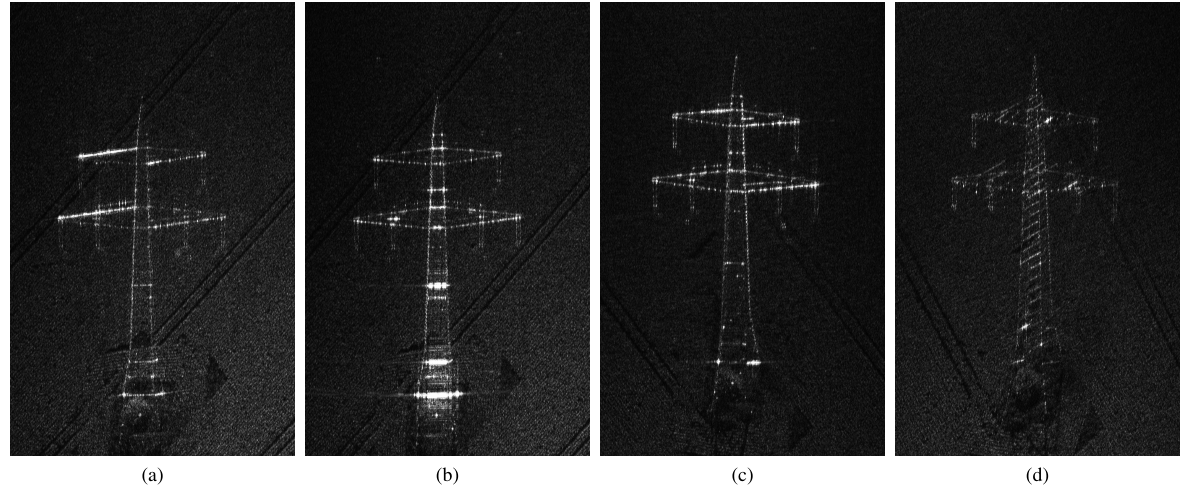
Figure 10. CSAR subaperture images of high electrical pylon on vertical focusing plane at 94 GHz from different viewing angles ϕ . Aspect integration is 2 . 5 ◦ . Theoretical resolution is 15 cm height and 4 cm length. (a) ϕ = 42 ◦ (b)